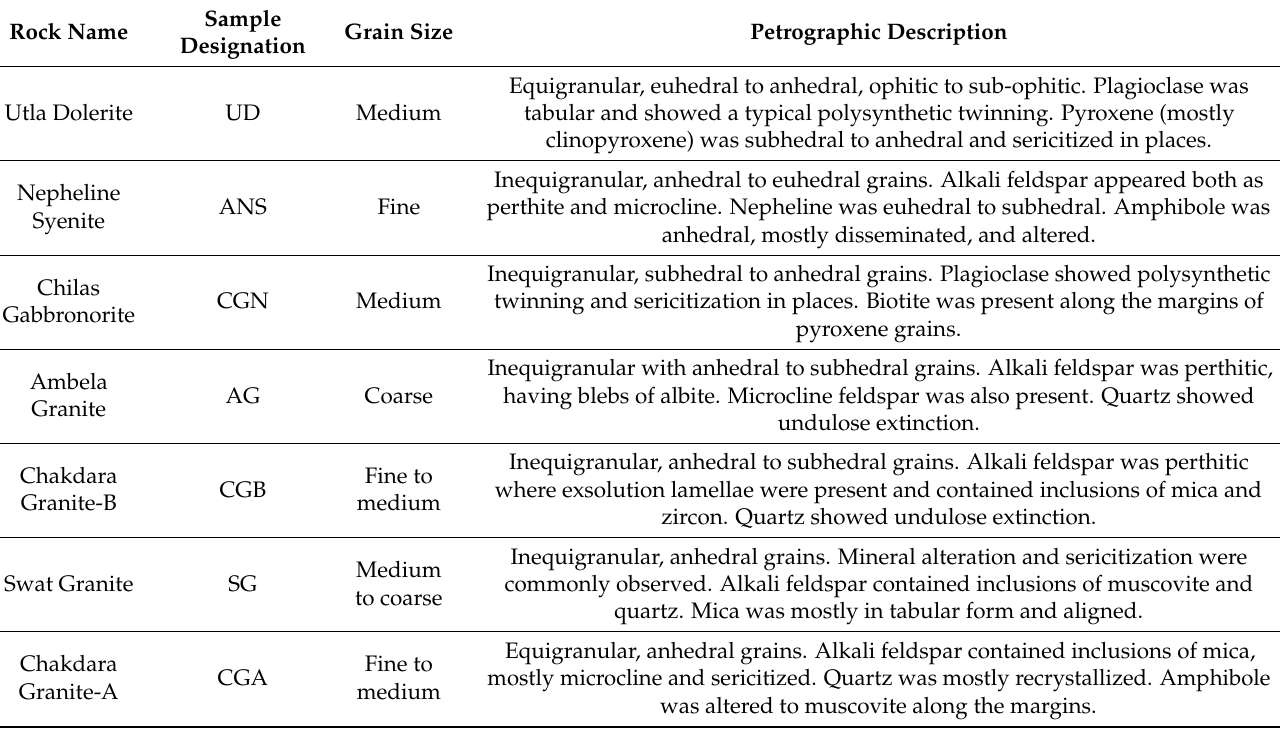
Table 1. Details of samples collected during the